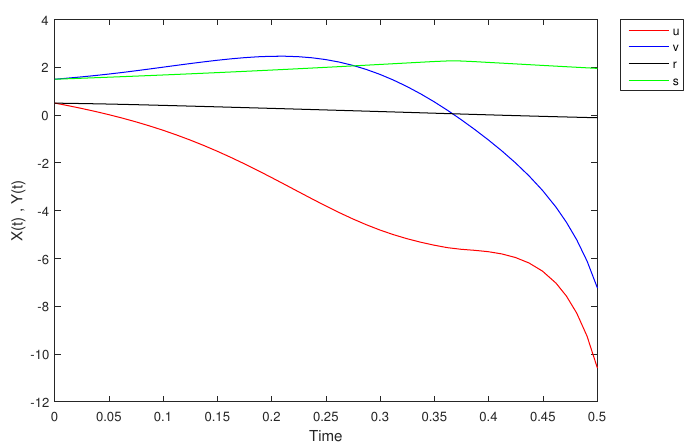
Figure 17. The solution of (10) at α = 0.0.